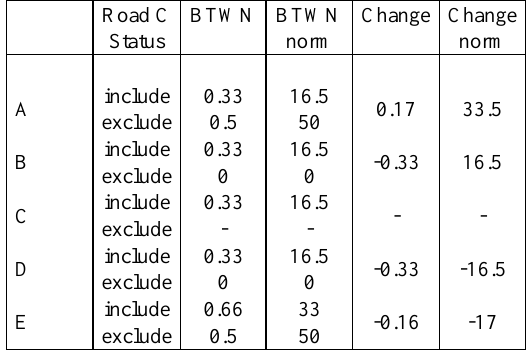
Table 2. Betweenness values and the changes of the